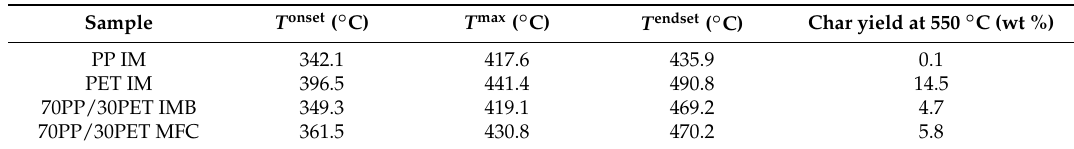
Table 1. Non-isothermal decomposition characteristics of PP IM, PET IM, 70PP/30PET IMB, and MFC in nitrogen.